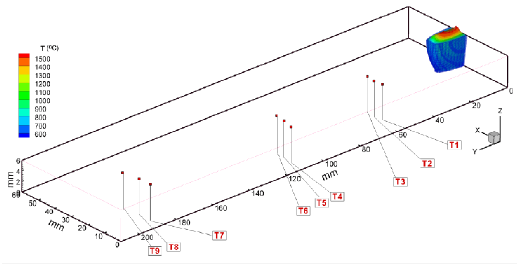
Figure 2. Temperature measurements arrangement using thermocouples and numerical predictions for first welding pass (t=10s and